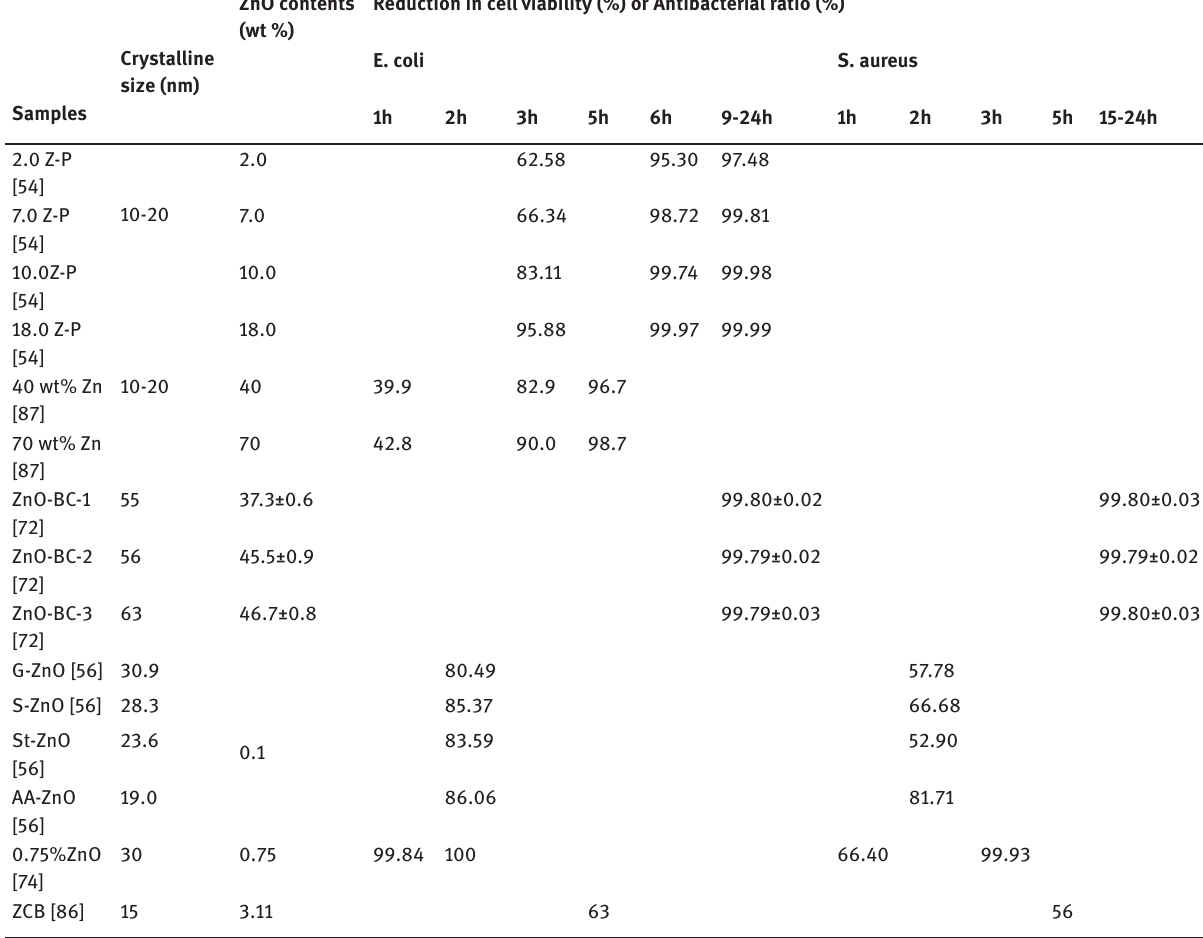
Table 4: Viable cell reduction activity of samples on E. coli and S. aureus.